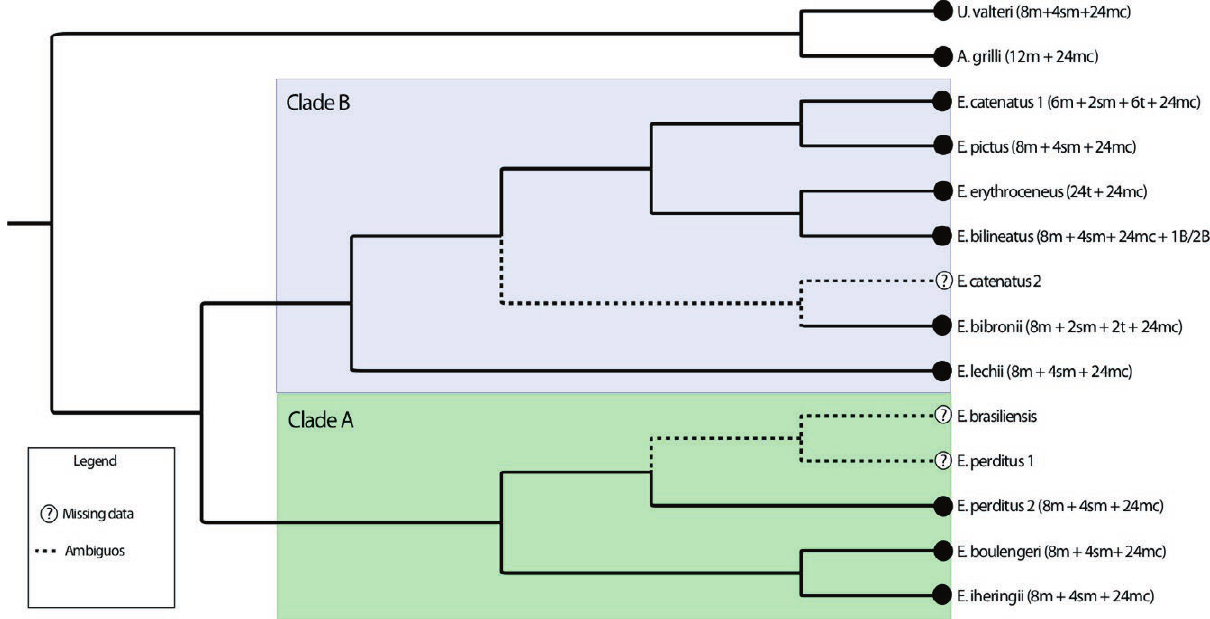
Figure 3. Compiled information about cytogenetic data in the genus Enyalius and some related species on a condensed phylogenetic hypothesis resulting from the analyses of Rodrigues et al.